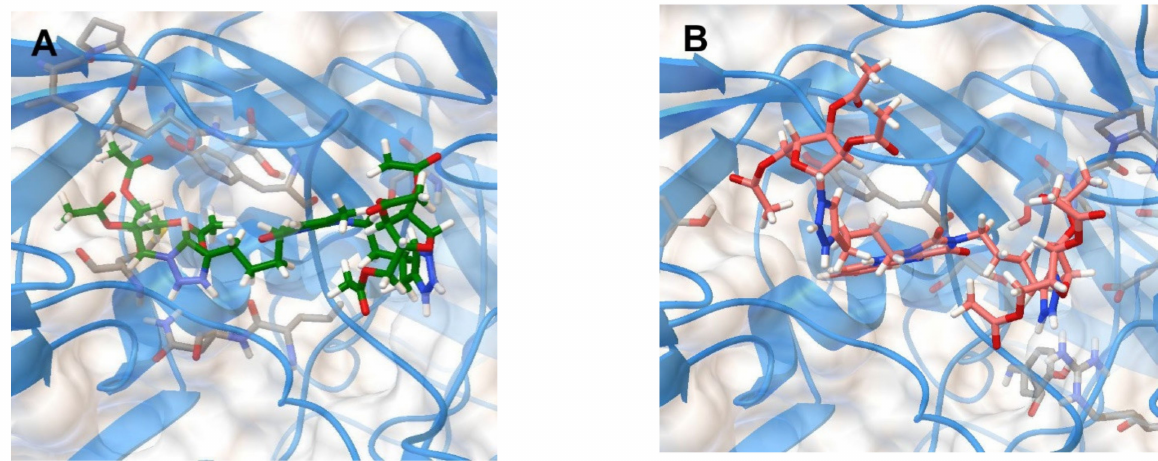
Figure 4. Molecular docking simulations of the optimized docking model of compounds 2f ( A ) and 5f ( B ) in the “canyon” of the coxsackievirus B3 coat protein (PDB code 1COV) obtained in the lowest-energy